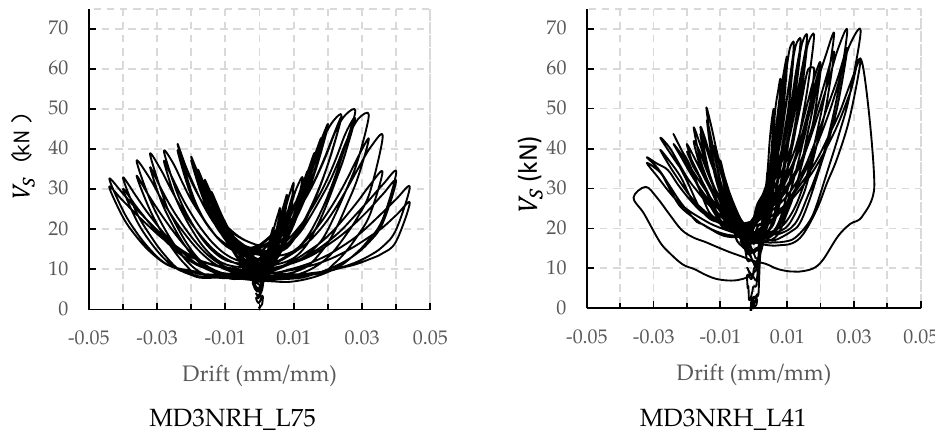
Figure 11. Contribution of joint reinforcement ( 𝑉 𝑆 ) — drift curves